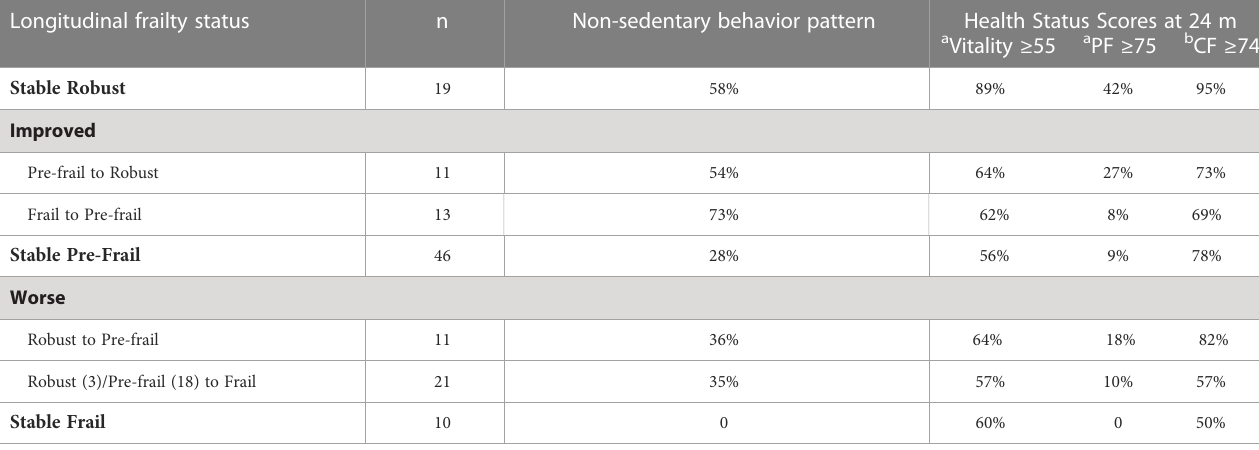
TABLE 5 Non-sedentary behavior over 24 months and health status scores at 24-months: Percentage of older persons with dialysis-dependent CKD, strati fi ed by longitudinal frailty status. Longitudinal frailty